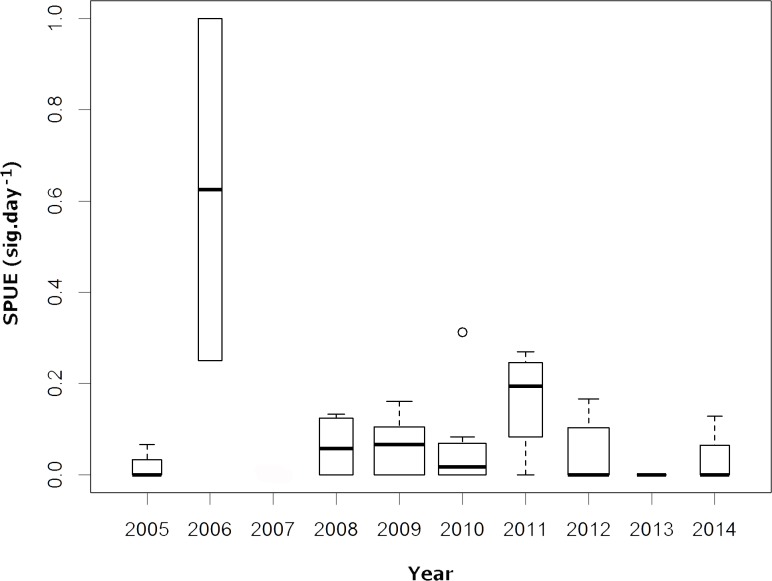
Distribution of whale shark sightings per year.SURV Sightings per Unit of Effort (SPUE; sig.day-1) per year of R. typus in the ASPSP. The width of the boxes is proportional to the square-roots of the number of observations in the groups, the horizontal bar is the median and the open circle indicates a single outlier.